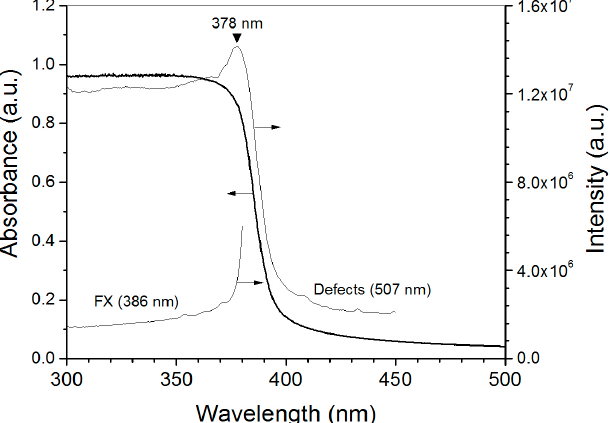
Figure 7. Diffuse reflectance spectroscopy (DRS) and photoluminescence excitation (PLE) spectra of the free exciton (FX) and defect–related emissions of the sample obtained after 24 min (S4) of thermal oxidation of Zn powders (900 ° C; air atmosphere).